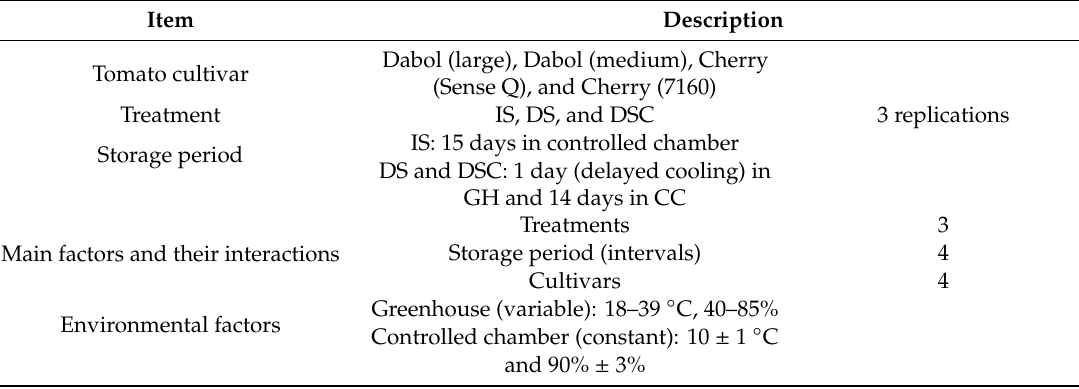
Table 1. Experimental design for the study under IS (immediate storage), DS (storage delayed 24 h), and DSC (storage delayed 24 h under cover) postharvest